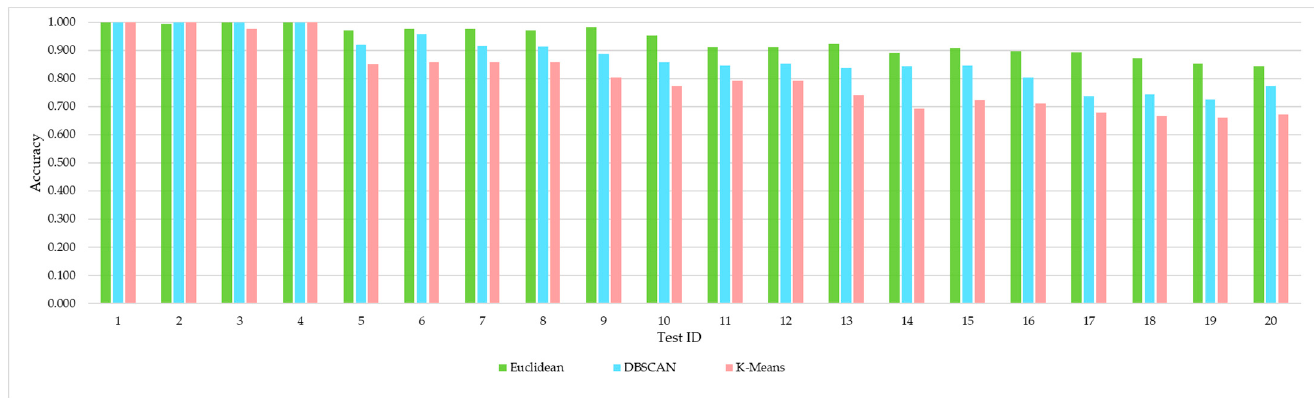
Figure 15. Accuracy of different clustering algorithms applied in presence detection function in different use cases. Table 4. Presentation detection results with or without clustering post-processing in static use cases.